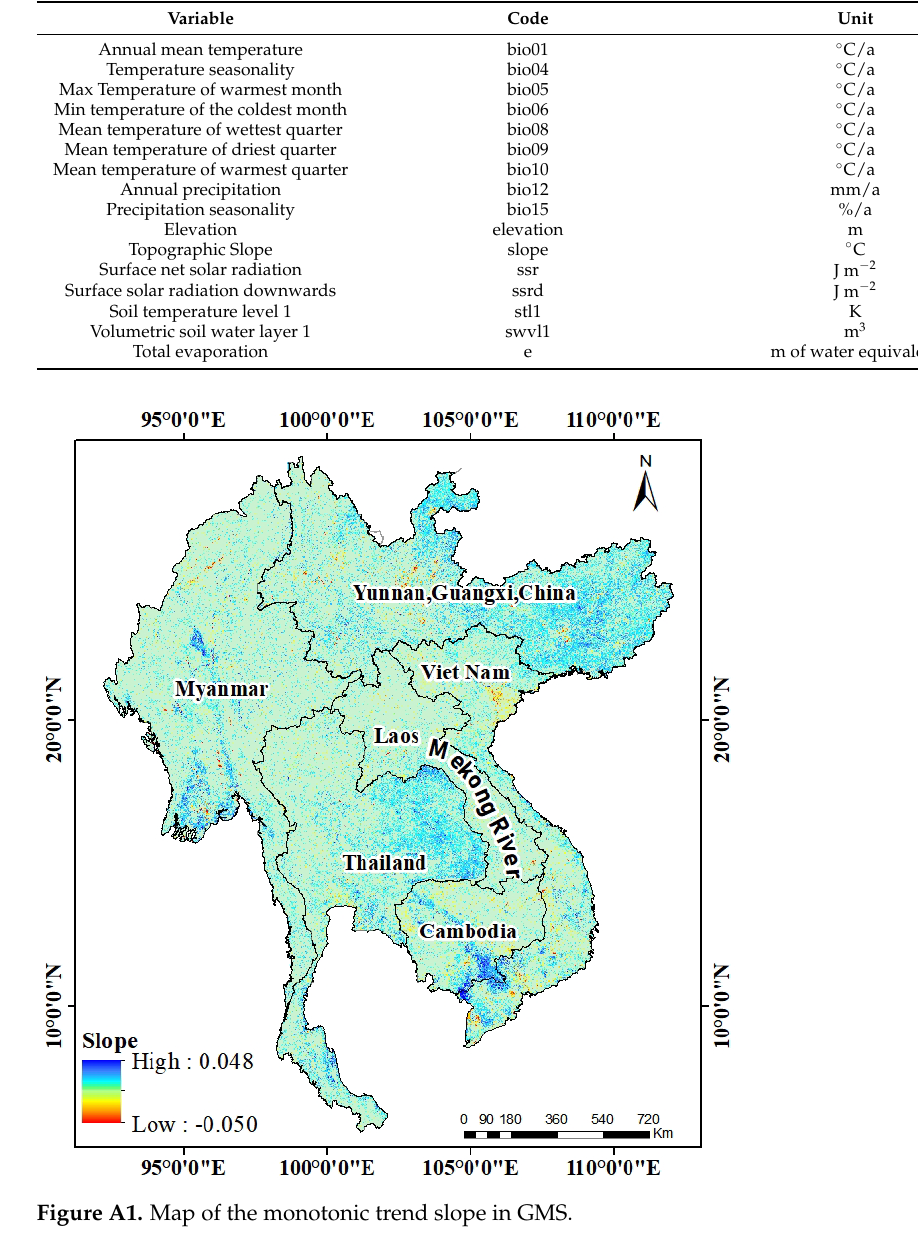
Table A2. Biometeorological and topographic factors.